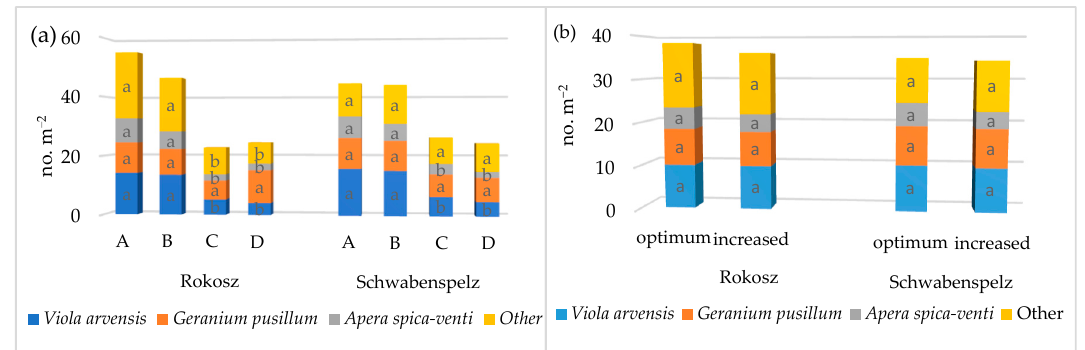
Figure 2. The impact of crop protection system on number of dominant weeds species 3–4 weeks after herbicide treatment in the spelt wheat cultivars "Rokosz" and "Schwabenspelz" (mean for 2013–2015). Different letters denote significant differences ( p ≤ 0.05) of number of weed species among different crop protection methods (A, B, C, D) ( a ) and seeding density ( b ). The same letter means not significantly different values.